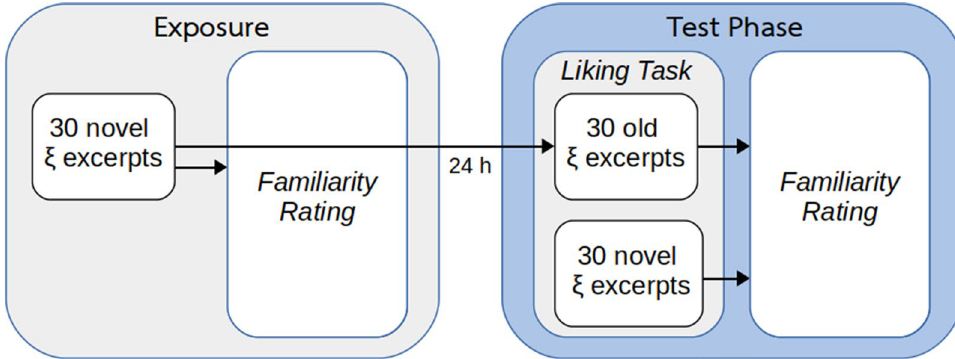
Figure 1. Experimental design diagram. During exposure, participants listened to 30 music stimuli randomly taken from a pool of 60 stimuli and rated their familiarity with the materials after each excerpt had been presented. Twenty-four hours later, participants listened to the same stimuli plus another 30 novel ones while continuously reporting the degree of pleasantness evoked. After each excerpt had been presented, participants rated their familiarity with the